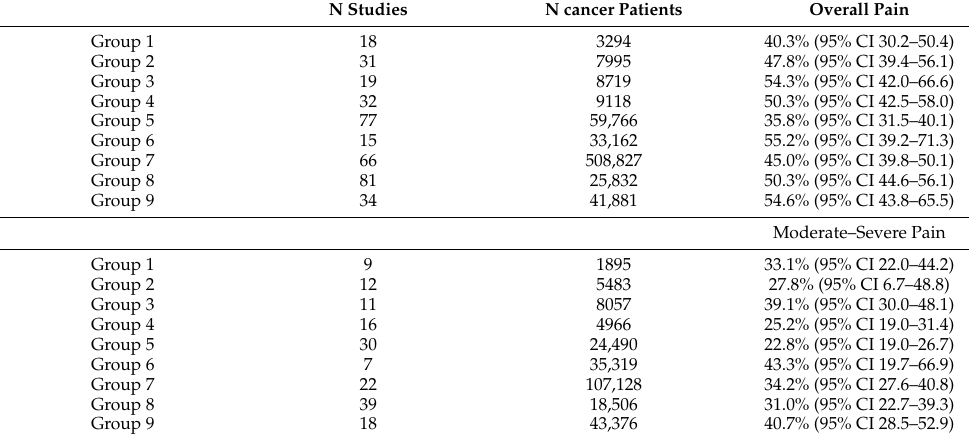
Table 9. Pooled pain prevalence, and severity rates by treatment group. N Studies N cancer